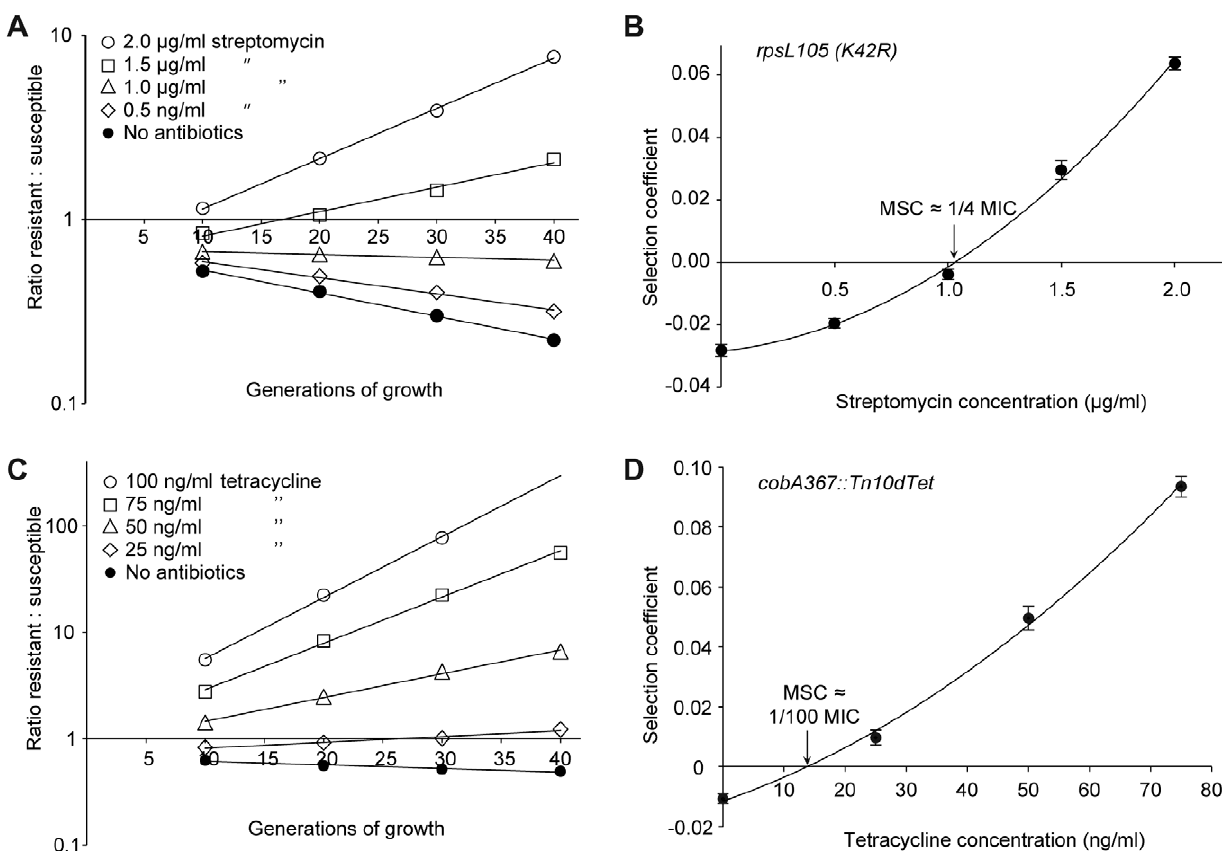
Figure 2. Competition experiments between susceptible and resistant strains, streptomycin and tetracycline. Competition experiments at different concentrations of antibiotics (A ( rpsL105 (K42R) ) and C ( Tn 10 d tet), and calculated selection coefficients as a function of antibiotic concentrations (B and D). Fig. A and C are each based on one single competition experiment (averages of four competitions), while Fig. B and D are calculated from the selection coefficients of up to 20 competitions (Table S3 in Text S1). Standard errors of the mean are indicated.